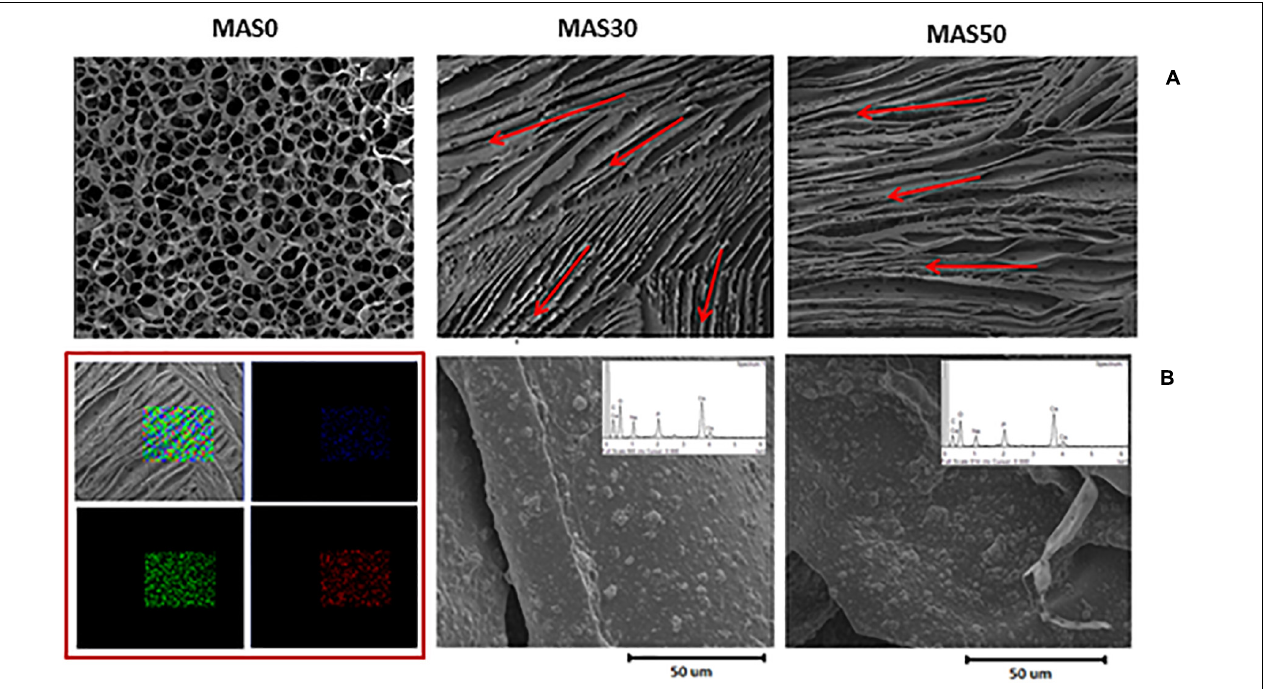
FIGURE 1 | Pore morphology of alginate porous sponges as a function of the HA volume fraction. (A) SEM images of sponge cross-sections (scale bar: 1 mm). Pores originated by the development of crystal domains with preferential orientation (see red arrows). This was determined by the presence of rigid HA phases that constrain the formation of pores to make them anisotropic. (B) SEM images of the pore surface to evaluate HA distribution. In the red square, EDS analysis and mapping for MAS30: the results confirmed the homogeneous elemental distribution along a portion of the surface -carbon (green), calcium (red), and phosphorus (blue).